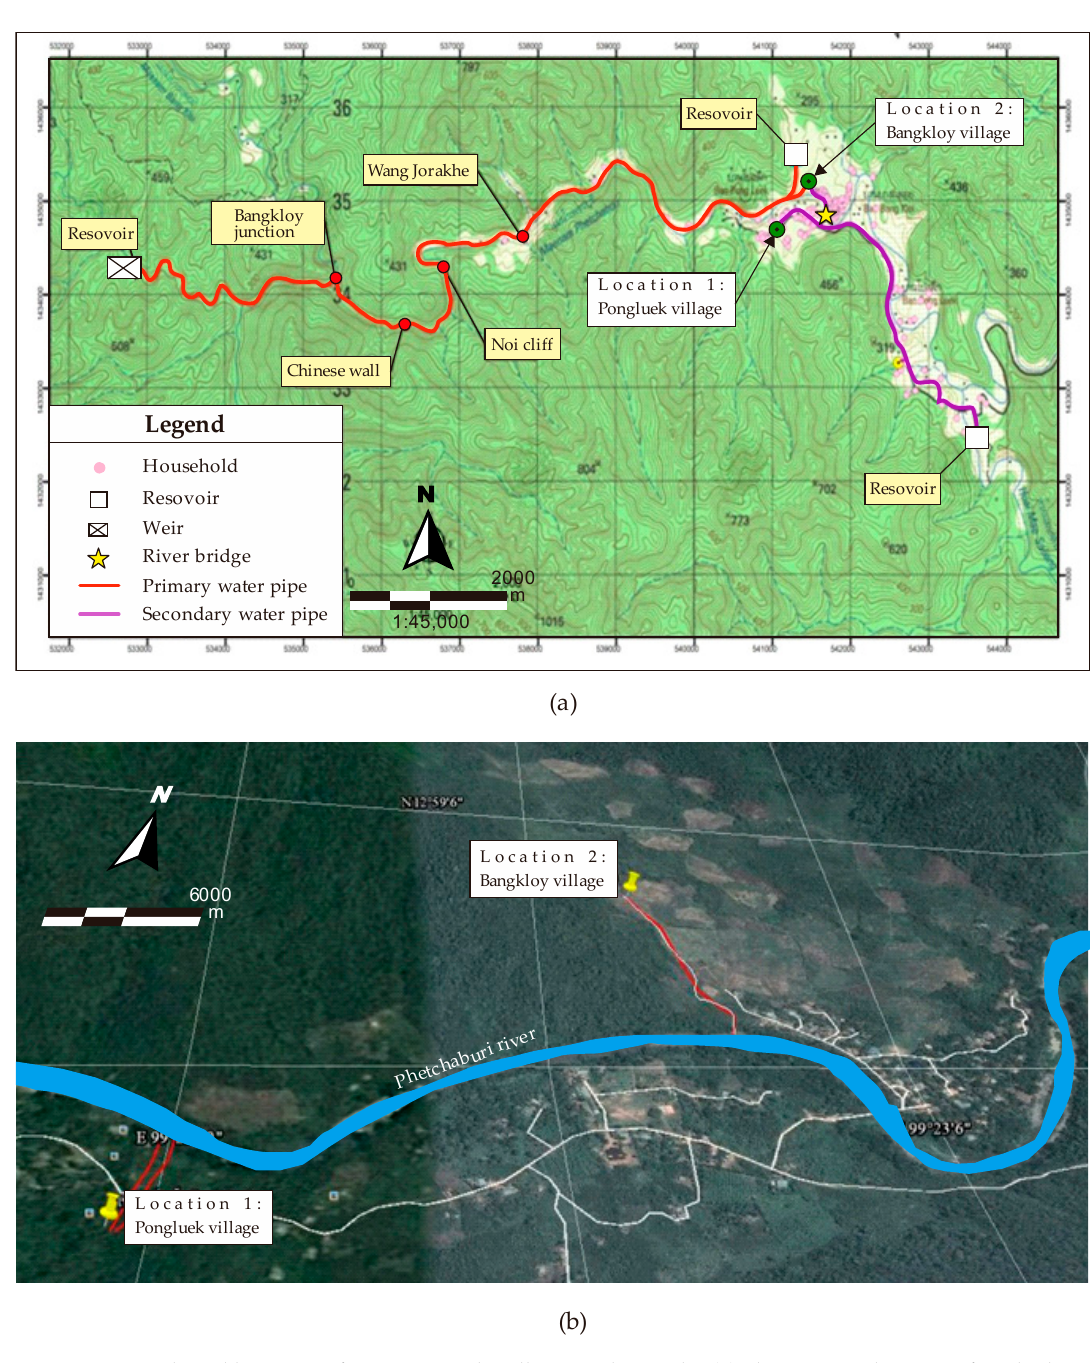
Figure 3. Selected locations of two case-study villages in this study: ( a ) The topographic map of studied locations; ( b ) the topographic map showing latitude and longitude of the studied locations.